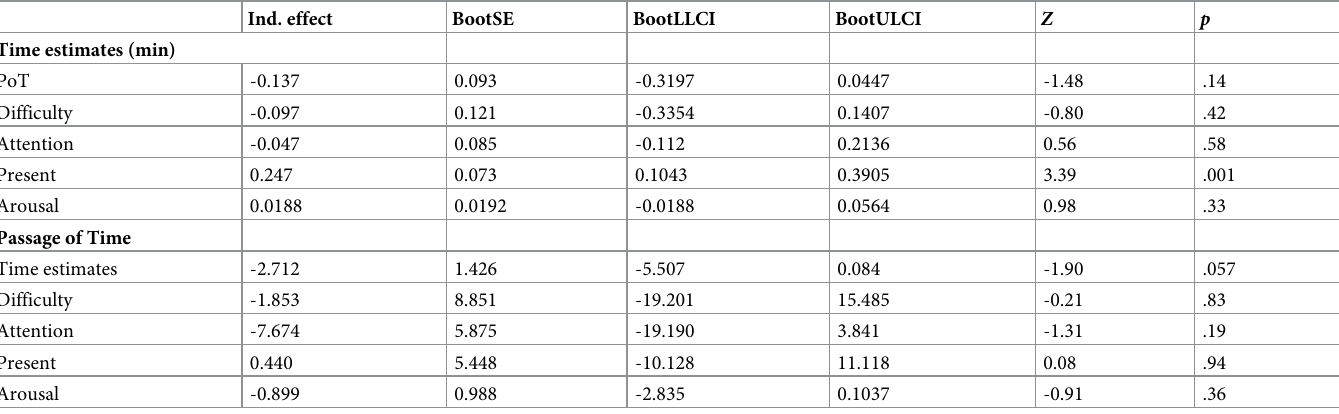
Table 5. Mediating indirect effects on the association between the mediation exercise and the time estimates (standardized errors) or the passage of time